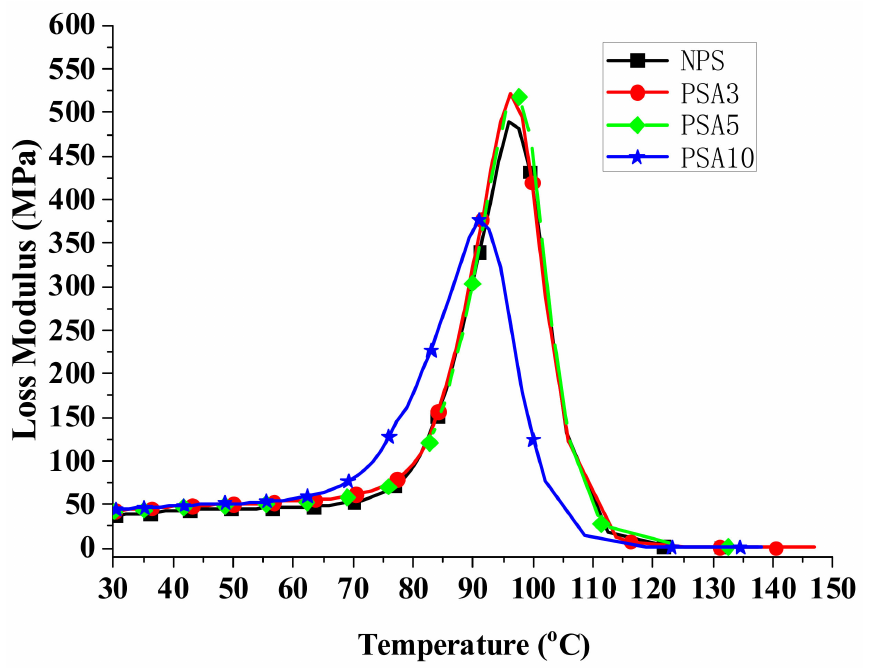
Figure 5. The measured loss moduli of Type I samples with respect to the temperature changes.